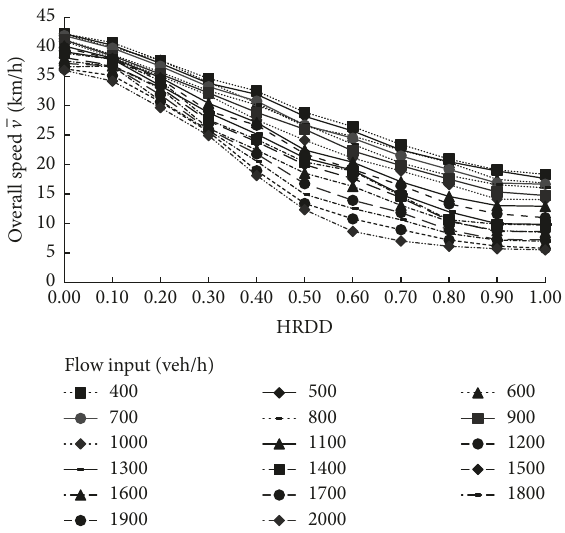
Figure 9: Relationship among v , HRDD, and flow input.